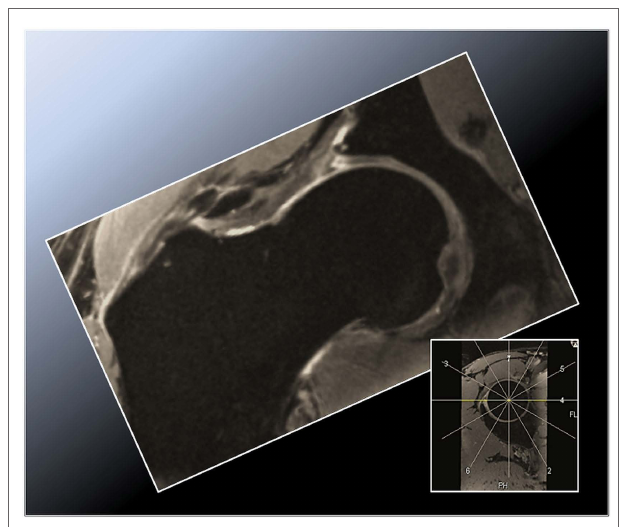
FiGURe 2 | Two-dimensional proton-density (PD) – weighted MR image of a pincer-type FAi patient depicting an increased signal within the center of the labrum that does not extend to the labral margin reflecting intra-labral degeneration. Note that the saturation effect (band of low signal in the center of acetabulum and femoral neck) is constantly present in 2D radial MR imaging.